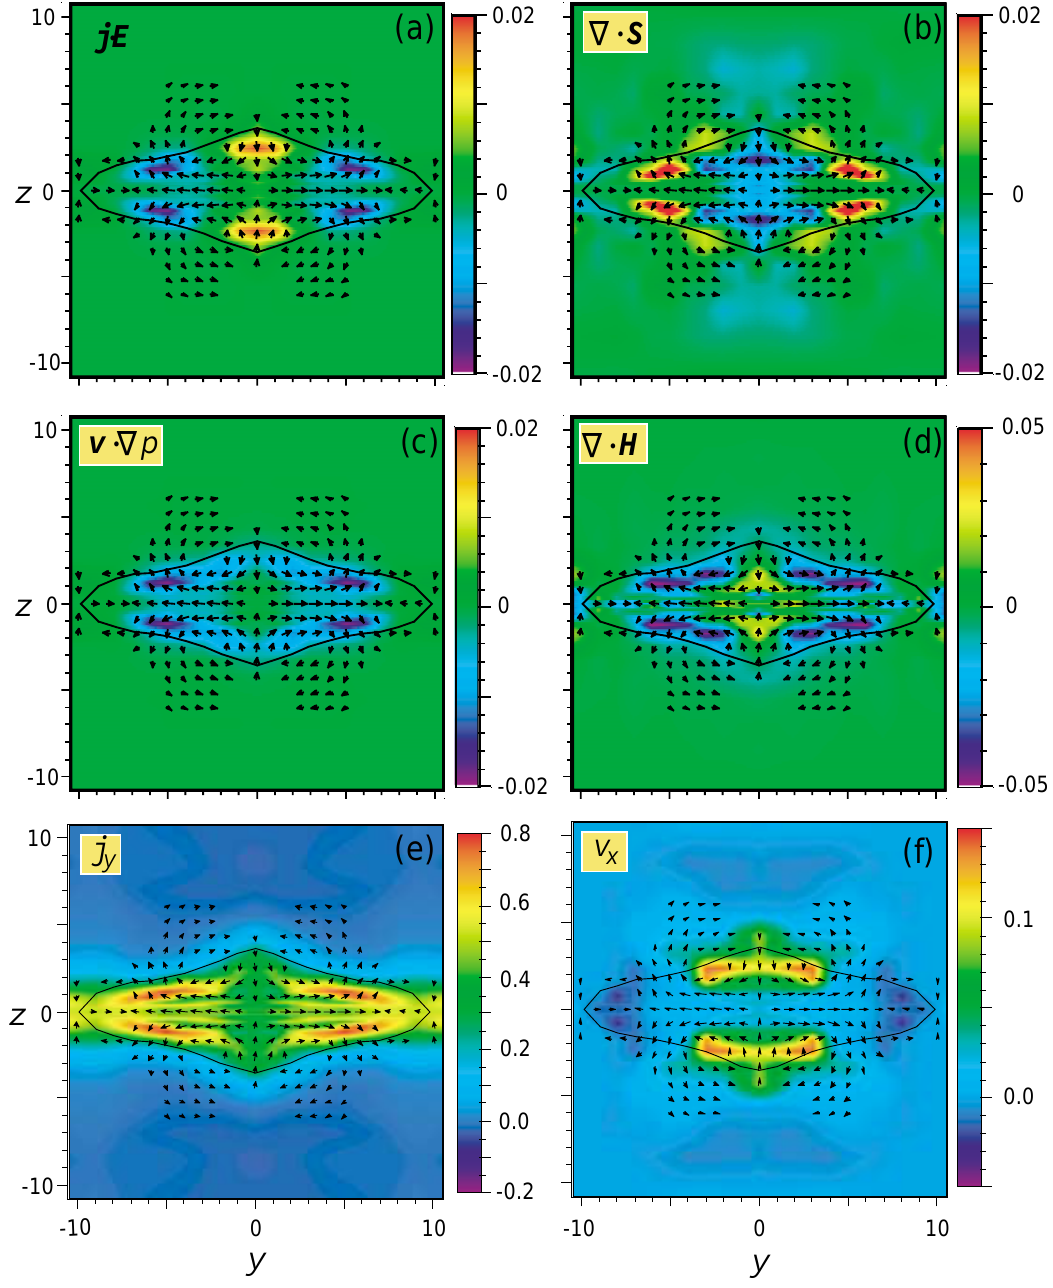
Fig. 8. Characteristic properties near the generator and load regions at x =− 8 . 75 for t = 100: (a) j · E , (b) ∇ · S , (c) v · ∇ p , (d) ∇ · H where H = (u + p) v , (e) cross-tail current density j y , and (f) earthward velocity v x . Note that the color scale in (d) differs from (a–c). Solid lines represent the boundaries of the closed field line region (separatrices) and arrows show the projection of velocity vectors perpendicular to the magnetic field. Panel (a) indicates generator regions (blue) near | y |= 5, where positive (earthward) Poynting flux is generated ( ∇ · S > 0, panel b). The generation mechanism involves a loss of enthalpy flux ( ∇ · H < 0, panel d) and mechanical work ( v · ∇ p< 0, panel c). The generator regions are also closely associated with bifurcated current layers (panel e), just outside of the earthward flow regions (panel f).